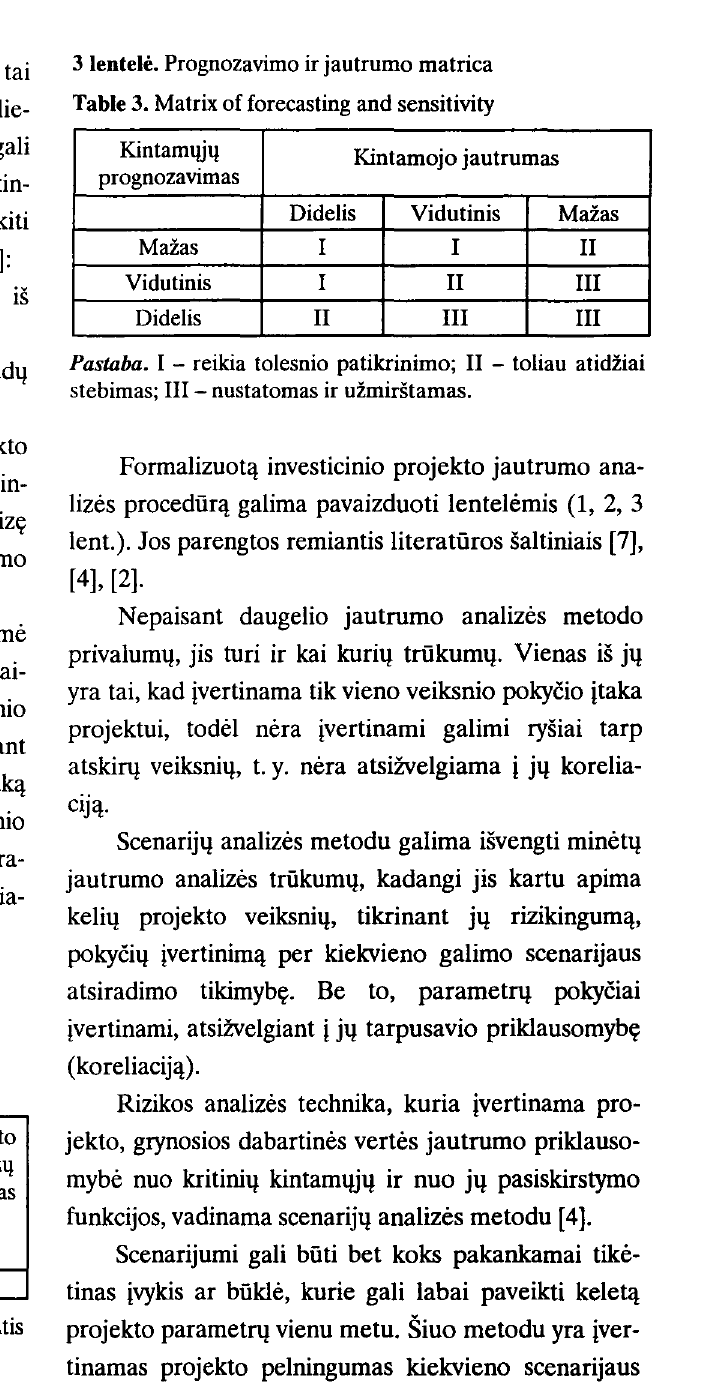
Table 2. Forecasting and sensitivity indexes of project variables Kinta- NPV Progno-